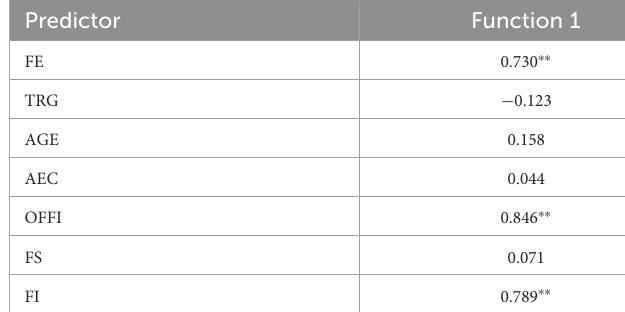
TABLE 5 Summary of unstandardized and standardized canonical discriminant function coefficients.